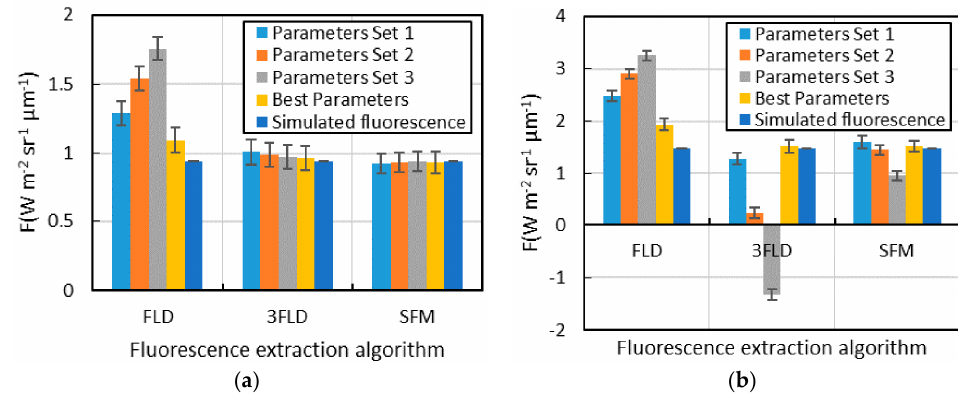
Figure 5. The fluorescence extraction results for each algorithm under different parameters set and the simulated value of fluorescence (the rectangle in this figure is the mean fluorescence, and the error lines represent the standard deviation); ( a ) O 2 -A absorption band; ( b ) O 2 -B absorption band.